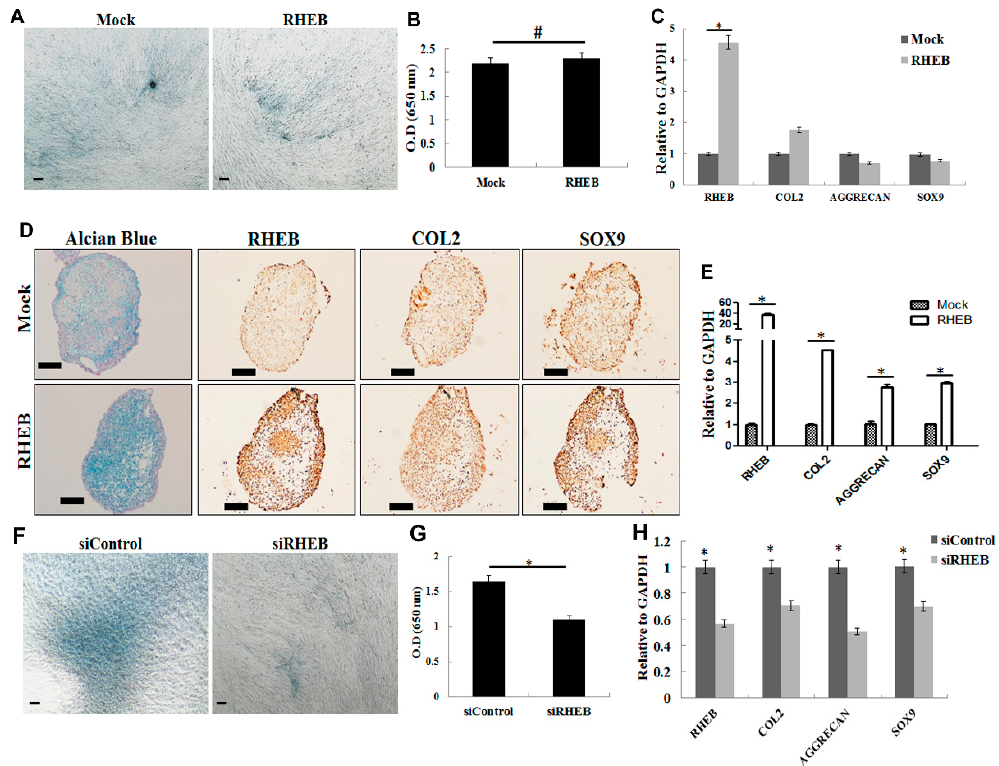
Figure 2. Effect of RHEB overexpression and knockdown on chondrogenic differentiation of ASCs in differentiation media. ( A ) Alcian blue staining in monolayer culture of ASCs after RHEB overexpression for evaluating glycosaminoglycan (GAG) matrix; ( B ) quantification of the Alcian blue staining extraction from monolayer cultured cells; ( C ) the mRNA analysis by quantitative real-time PCR from monolayer cultured ASCs; ( D ) pellet culture; Alcian blue staining, immunohistochemistry (IHC) was performed for determination of RHEB, COL2 and SOX9 expression; ( E ) the mRNA expression analysis by quantitative real-time PCR in pellet culture; ( F ) Alcian blue staining in monolayer culture ASCs after RHEB knockdown; ( G ) quantification of the Alcian blue staining extraction in RHEB knockdown ASCs; ( H ) the mRNA expression analysis in monolayer cells after RHEB knockdown. (Data are shown for a representative experiment as averages of triplicates with standard deviation. The statistical significance of differences was calculated using the Student’s t -test. * p < 0.05; Scale bar: 100 μ m).